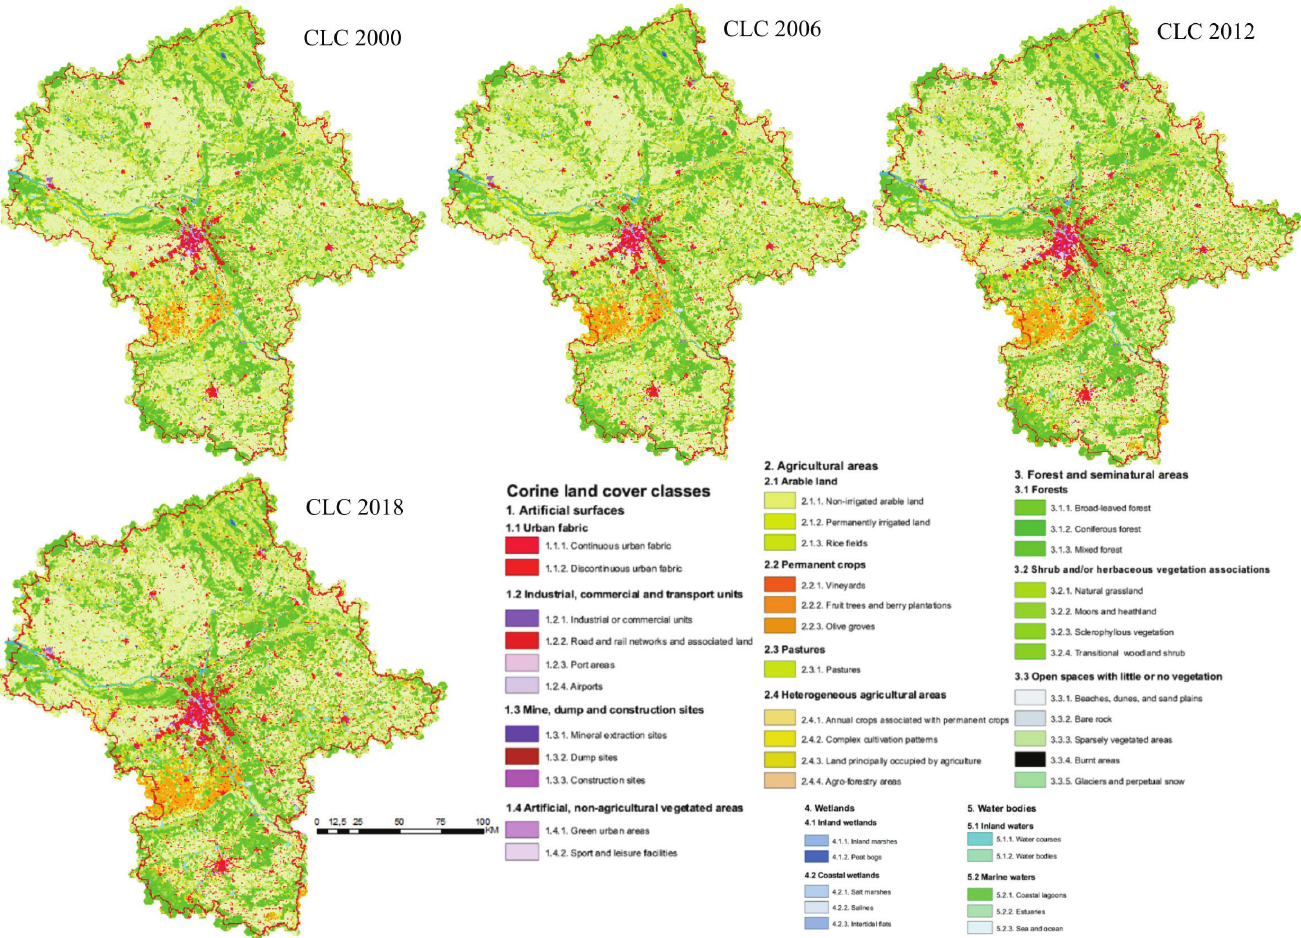
Figure 3. Land cover maps of the Mazovian Voivodeship based on CORINE Land Cover data for 2000, 2006, 2012 and